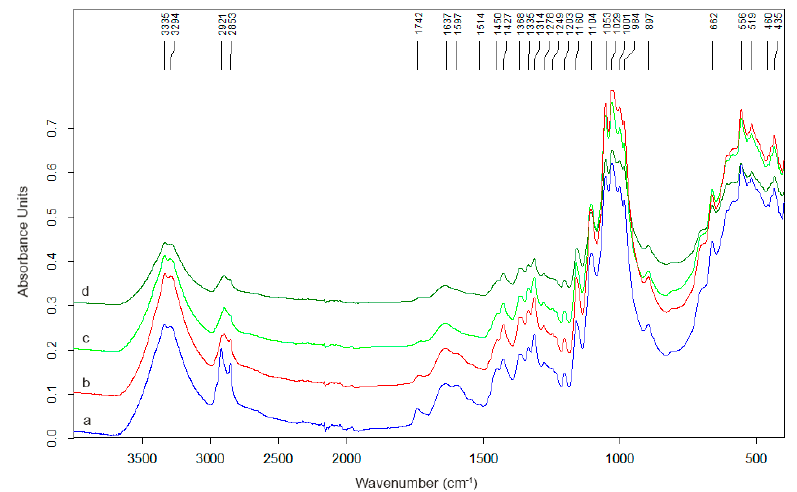
Figure 5. Infrared spectra of neat ( a ) and enzymatically modified flax yarns using 2.5 wt % Peclyve for 3 h ( b ), 4.5 h ( c ) and 6 h ( d ).